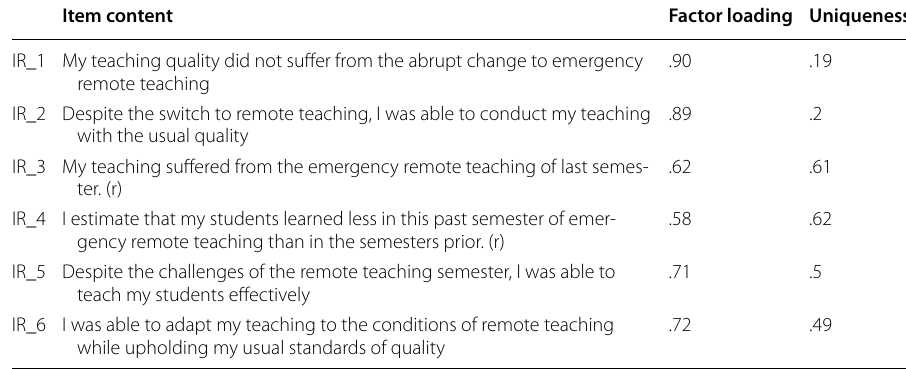
Table 4 Items, factor loadings, and uniqueness for instructional resilience construct Item content Factor loading